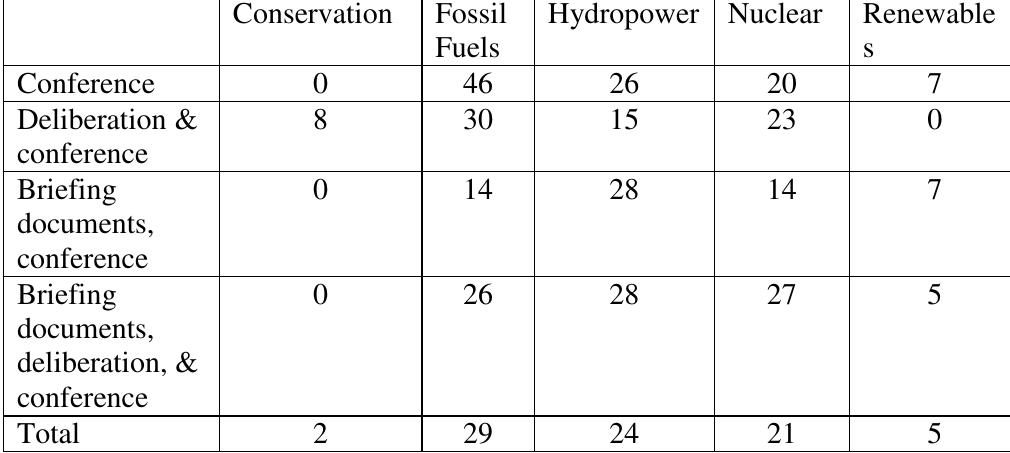
Table 3. Percentage of Respondents (n=61) Exhibiting Substantive Attitude Changes between Pre-Test and Post-Test, by Treatment and Energy Option Conservation Fossil Hydropower Nuclear Fuels